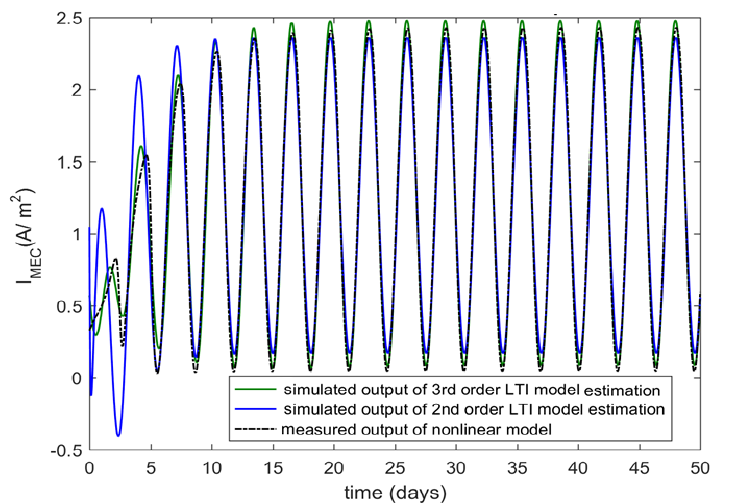
Figure 5. Plot of generated model results that were validated for sinusoidal